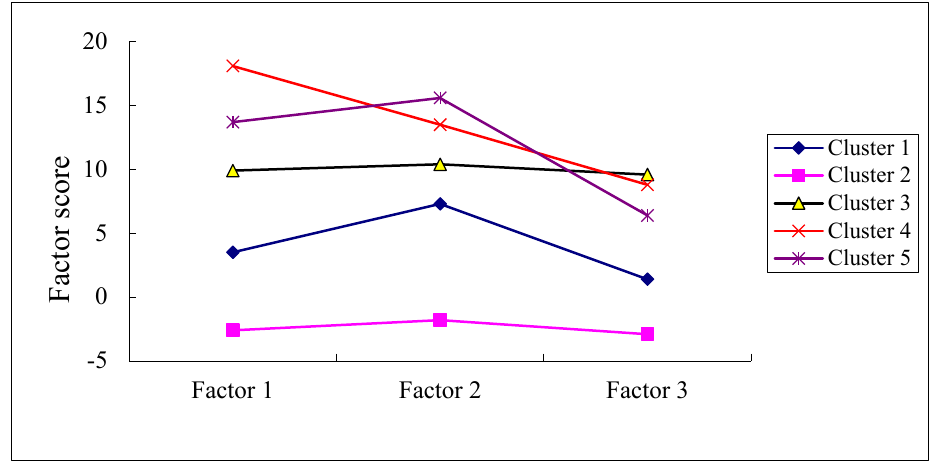
Figure 2. Factor scores of the five clusters. Table 4. Average and maximum values for the VOCs in various clusters.